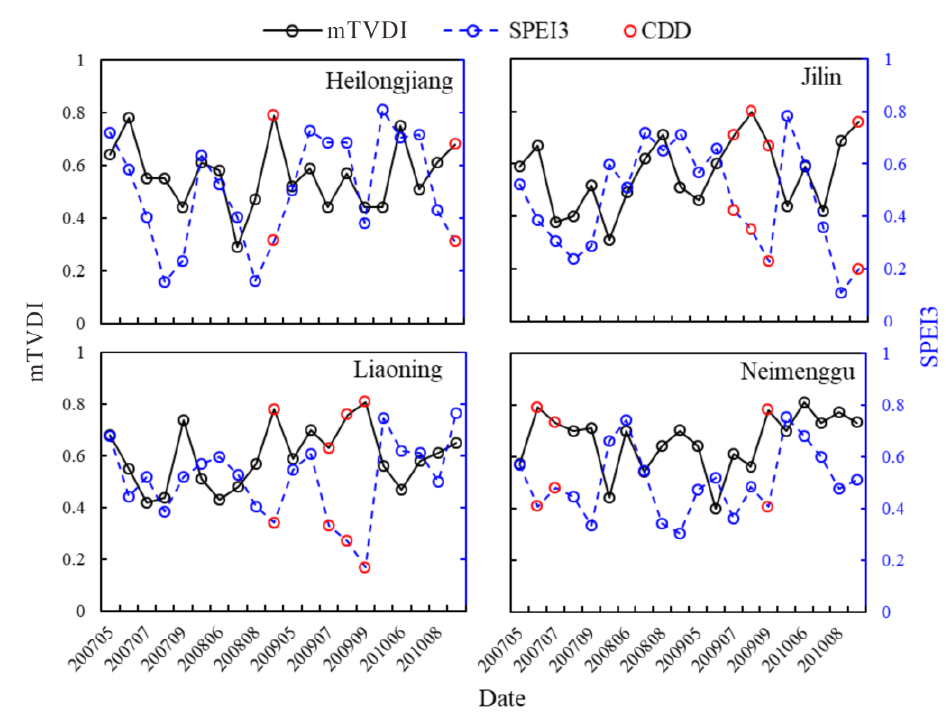
Figure 11. Validation of the mTVDI and SPEI3 with the CDD (red marks represent the recorded drought events).